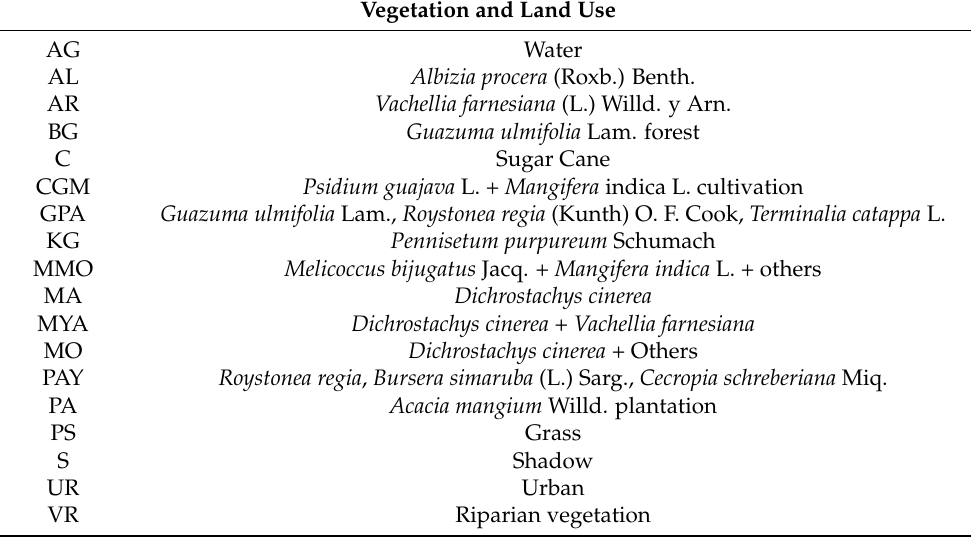
Table 1. Classification of land-use and vegetation types based on spectral signatures of WorldView-2 image of Trinidad-Valle de los Ingenios,